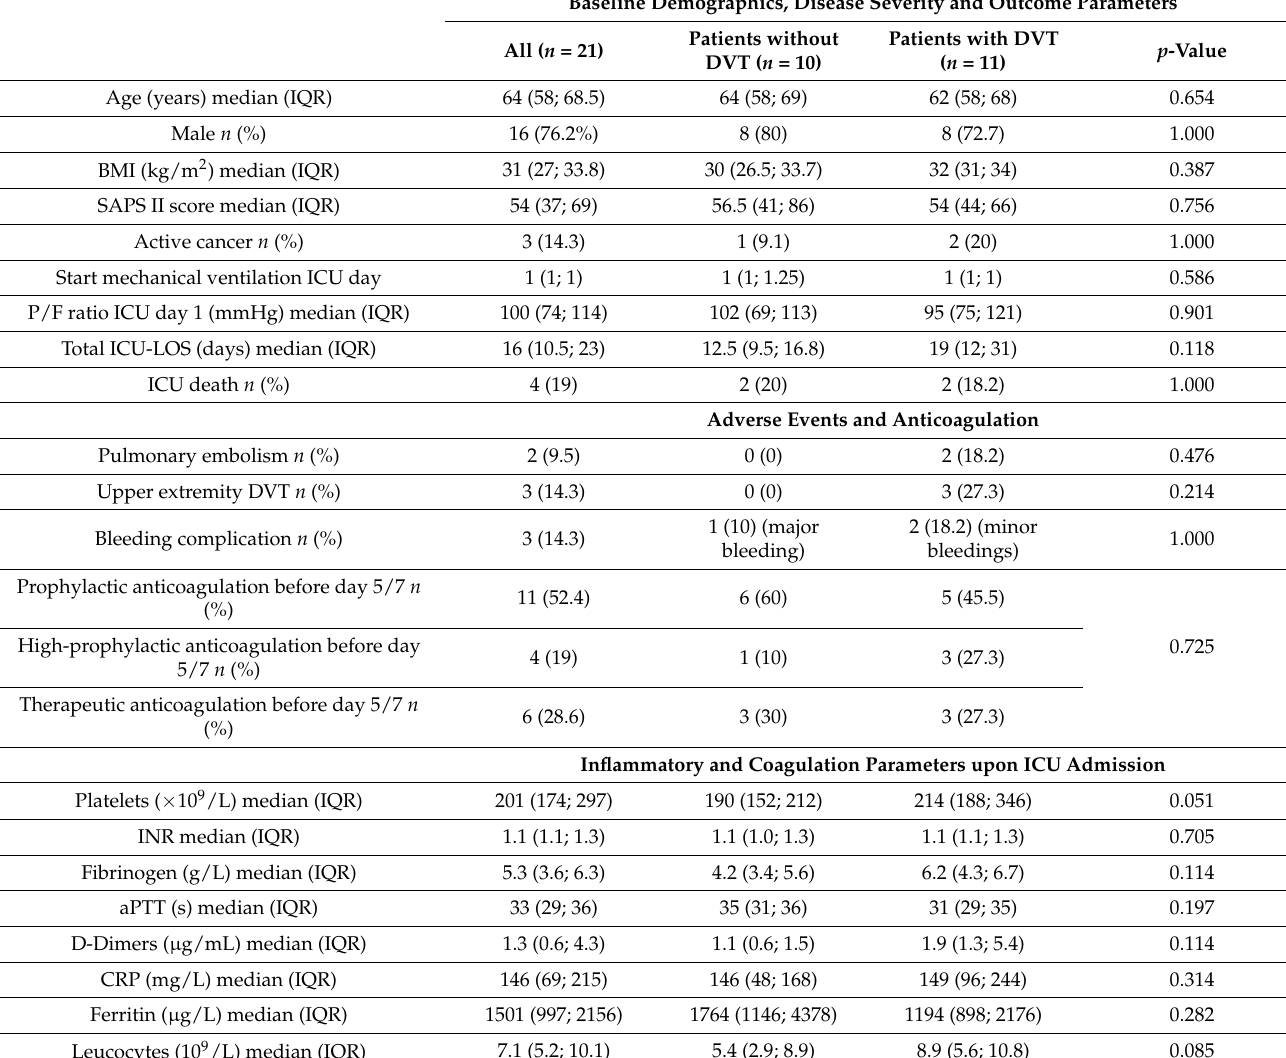
Table 1. Baseline demographics, clinical, laboratory and outcome parameters in patients with coronavirus disease 19 undergoing ultrasound screening for DVT. Baseline Demographics, Disease Severity and Outcome Parameters Patients without Patients with DVT p All ( n = 21) DVT ( n = 10) ( n = 11)